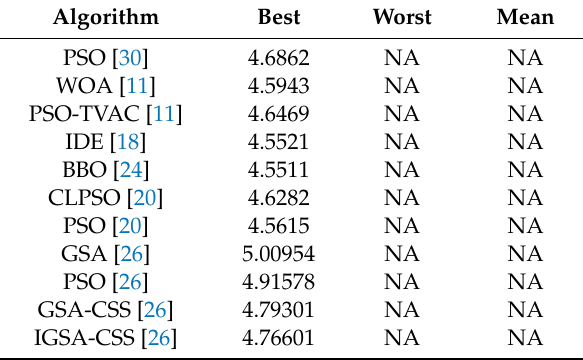
Table 4. Comparison of simulation results for VD minimization.